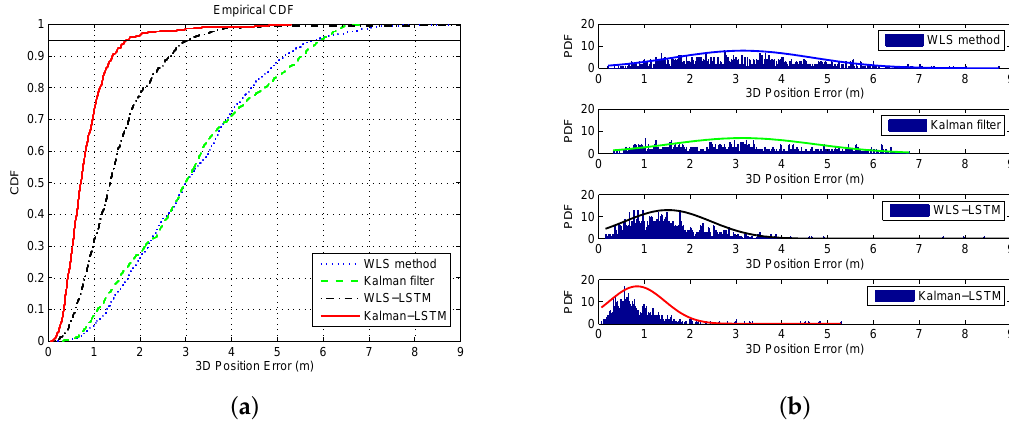
Figure 16. The CDF and PDF of four different methods: ( a ) CDF; and ( b ) PDF.